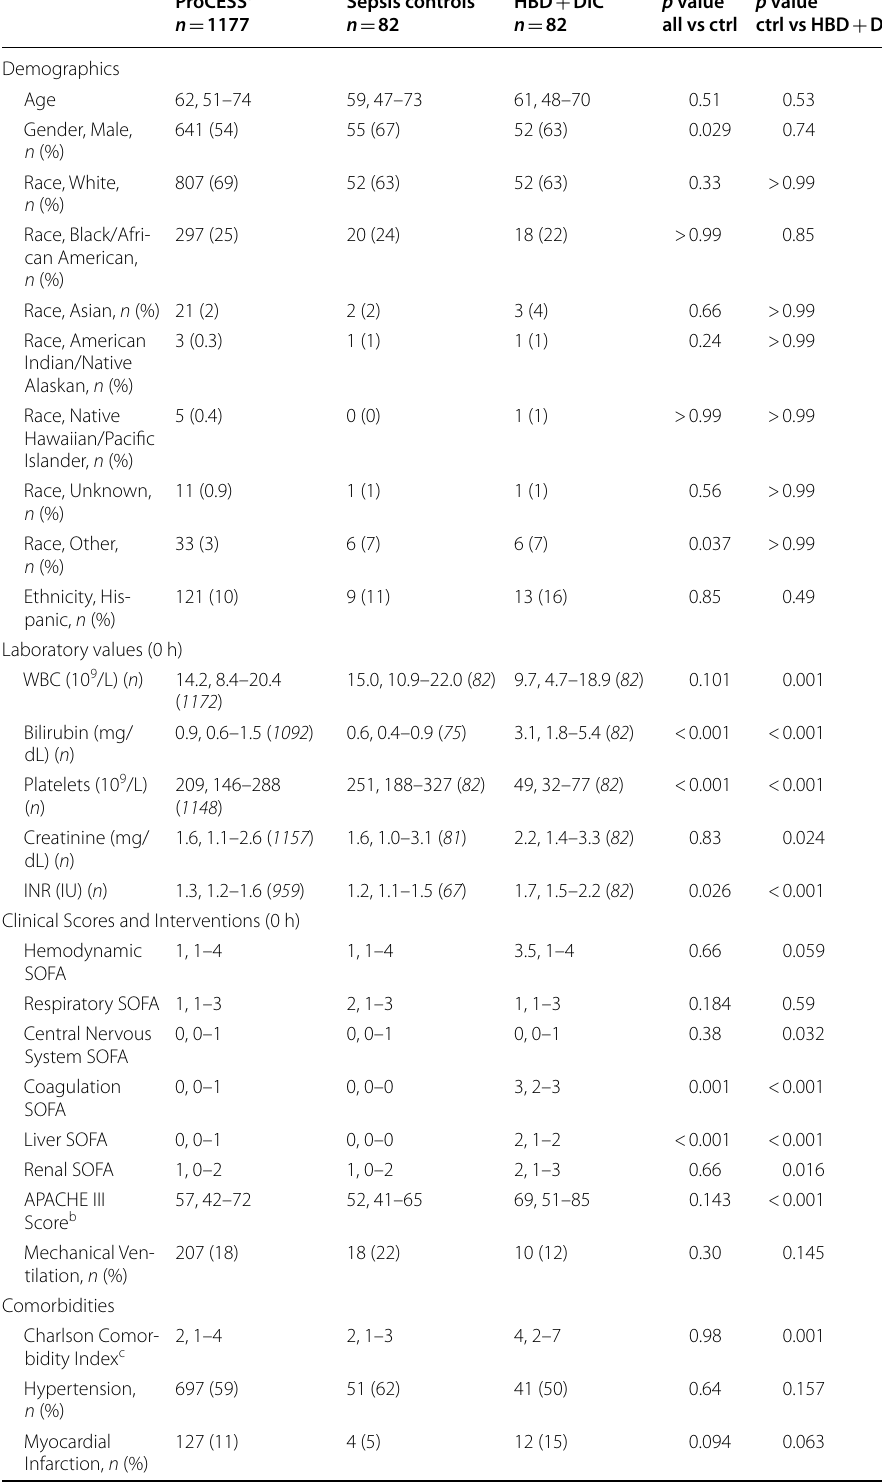
Table 1 Clinical characteristics of septic shock patients from the ProCESS cohort